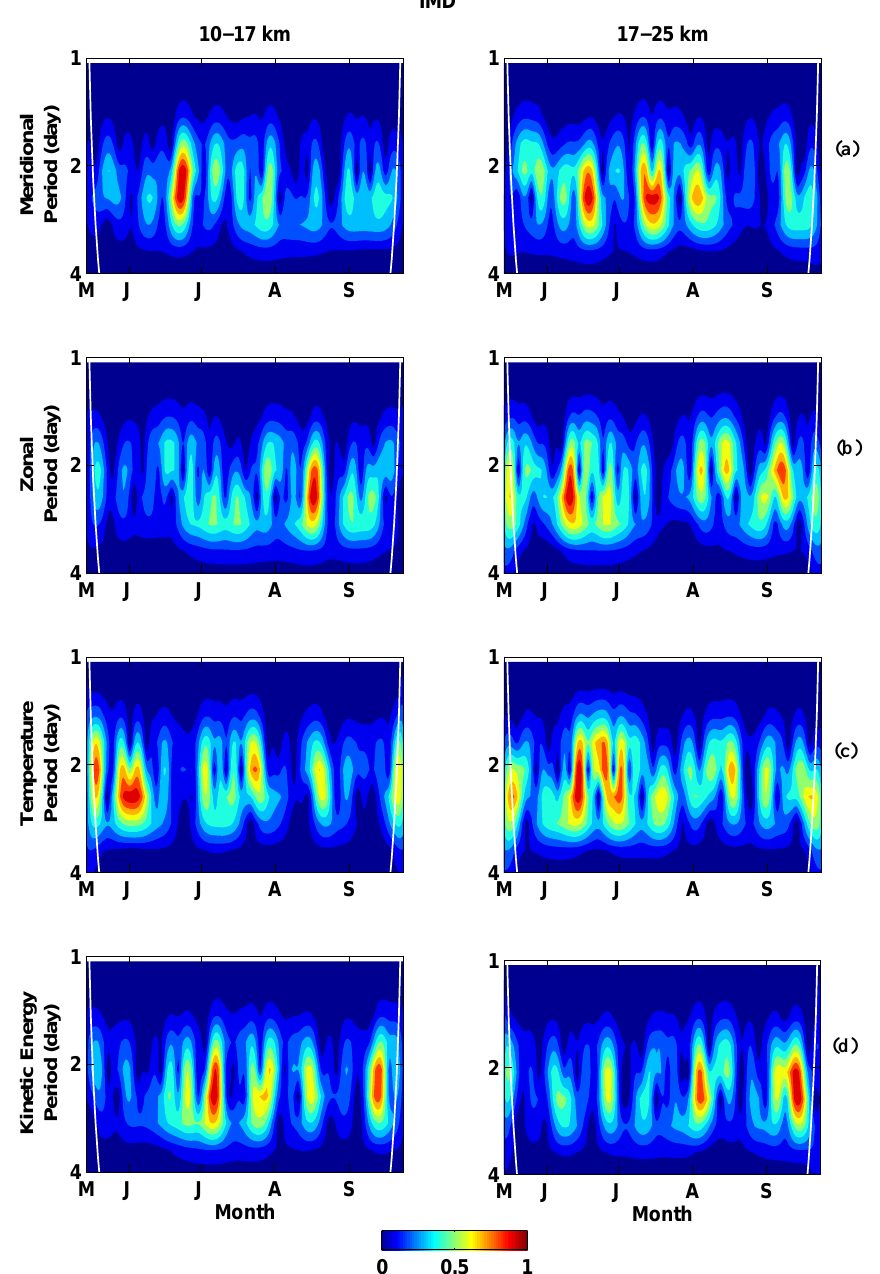
Fig. 6. Wavelet transform spectra of meridional (a) , zonal (b) winds, temperature (c) and kinetic energy (d) for 10–17km and 17–25km altitude blocks (IMD data). Lower portions of cones of influence have been truncated for